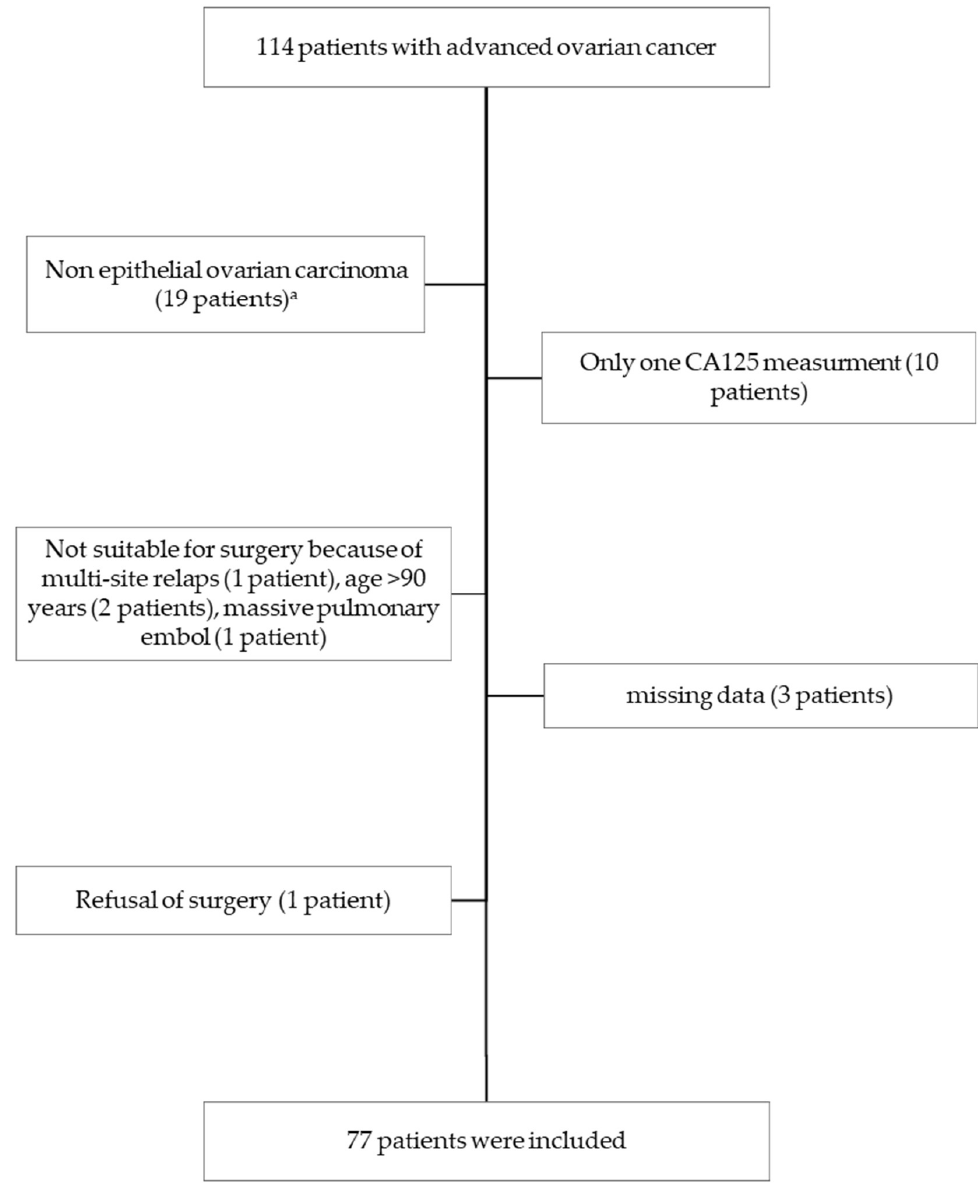
Figure 1. Flow Chart. a 5 borderline, 4 mucinous, 3 carcinosarcoma, 2 endometrioid, 1 Sertoli cell, 1 granulosa tumor, 1 independent cell, 1 clear cell, and 1 mixed Mullerian . Table 1. Demographic, clinical, and biological characteristics.